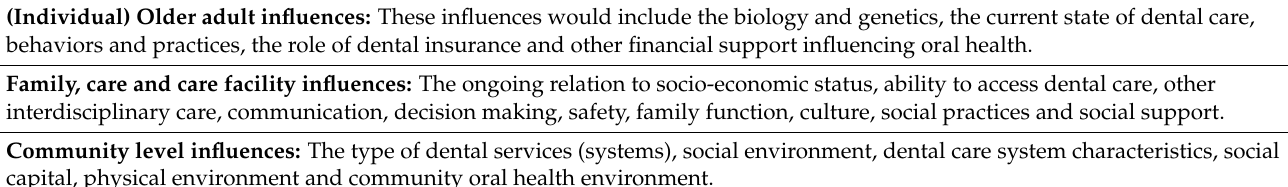
Table 1. Influences on oral health in older adults-adapted from Fisher-Owens